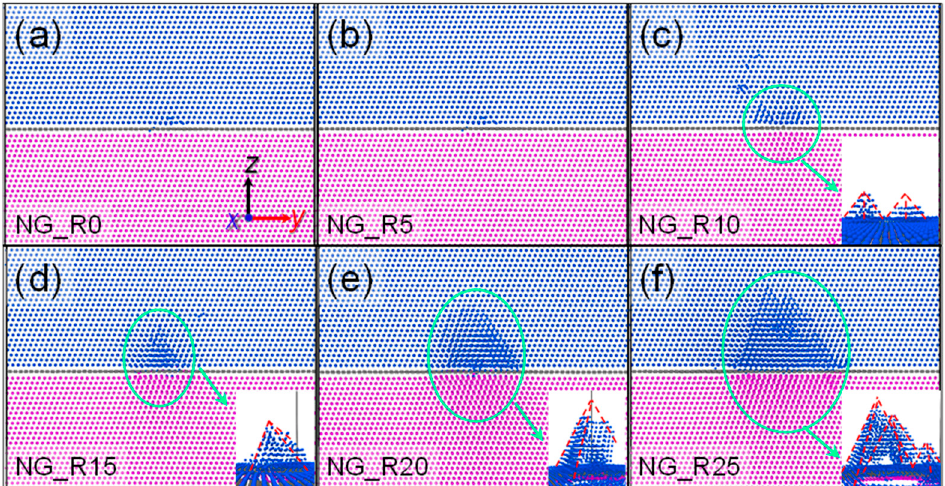
Figure 7. Snapshots of the six pure Ni models extracted from the ending moment of cascades. ( a ) N_R0. ( b ) N_R5. ( c ) N_R10. ( d ) N_R15. ( e ) N_R20. ( f ) N_R25. SFT-like structures are labeled. 3.2. Defective Graphene’s Effect on He Diffusion The He diffusion behavior near the NGI with defective Gr at 823 K is shown in Figure 8. At the beginning, 928 He atoms are separated from each other and distributed at differ- ent random tetrahedral interstitial sites in the system. At 0.005 ns, several small He n clus- ters ( n up to 4) start to form in the bulk. At 0.015 ns, the sizes of the He clusters further increase, and the largest cluster consists of seven He atoms. At 0.03 ns, because of the trapping of NGI, isolated He atoms rarely survive near the interface. We can observe one significant He diffusion phenomenon from the He atoms entering their opposite bulk, which becomes more pronounced with time. At 0.05 ns, several He clusters close to the interface can exist stably and even grow further, instead of being trapped by the NGI, implying that the clusters have been pinned and become stable nucleation sites. For ex- ample, a He 7 cluster is generated at 0.03 ns and remains in its configuration at 0.05 ns, and a He 5 grows to be a He 8 . At 0.1 ns, the number of He clusters is almost comparable to that